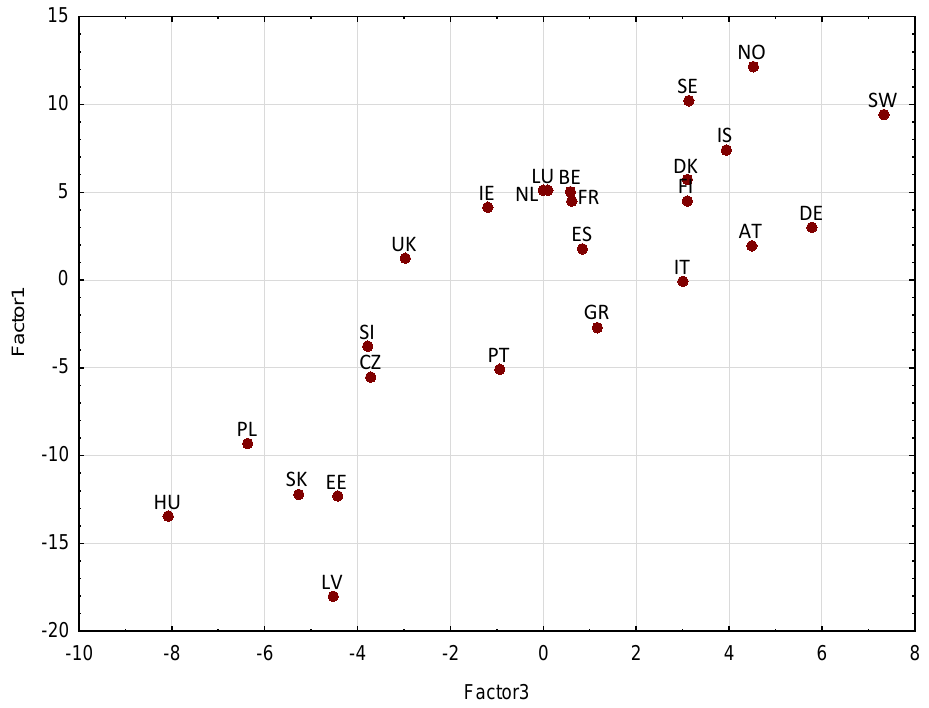
Figure 4. Location of European countries in the coordinate system of the factors F3, F1. Source: self-processed in Excel